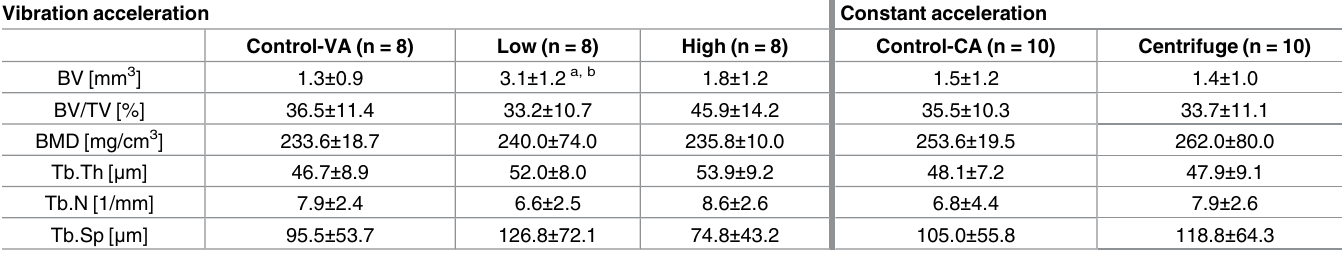
Table 3. Micro-CT analysis of ectopic bone among vibration and constant acceleration